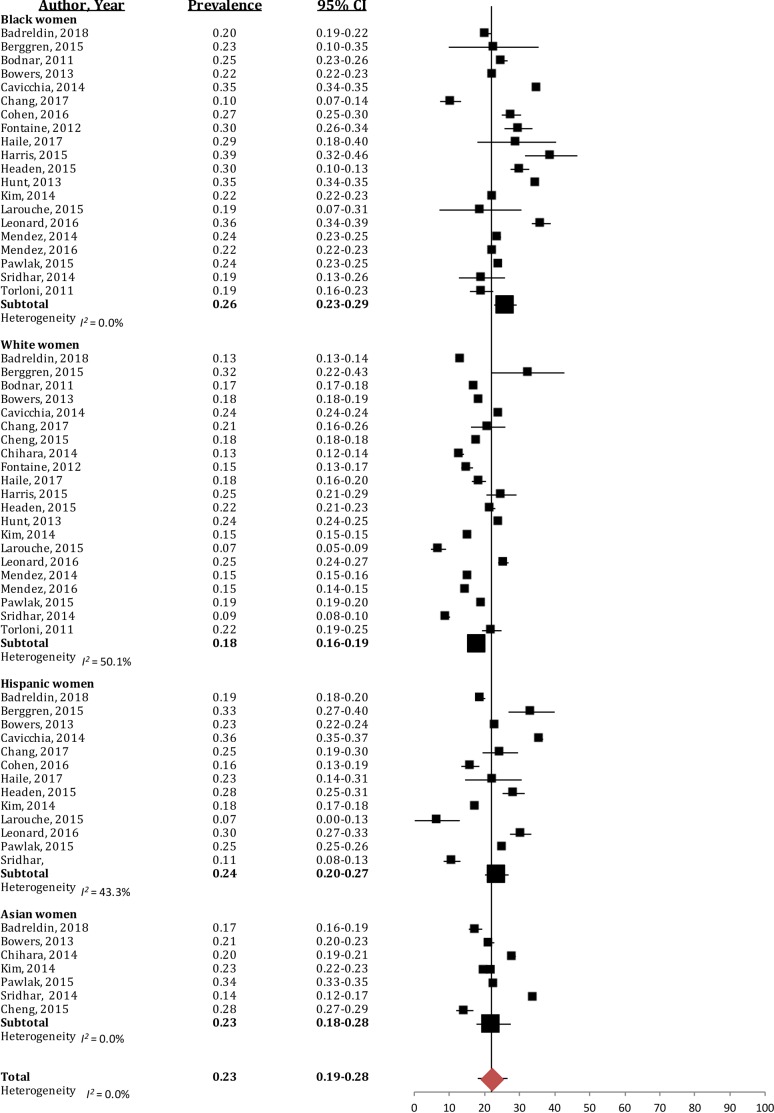
Forest plot of the prevalence of inadequate gestational weight gain in Black, White, Hispanic and Asian women.The prevalence of women gaining below the 2009 IOM gestational weight gain guidelines, broken down by racial/ethnic groups. Large black sqaure represents the weighted prevalence in each group.